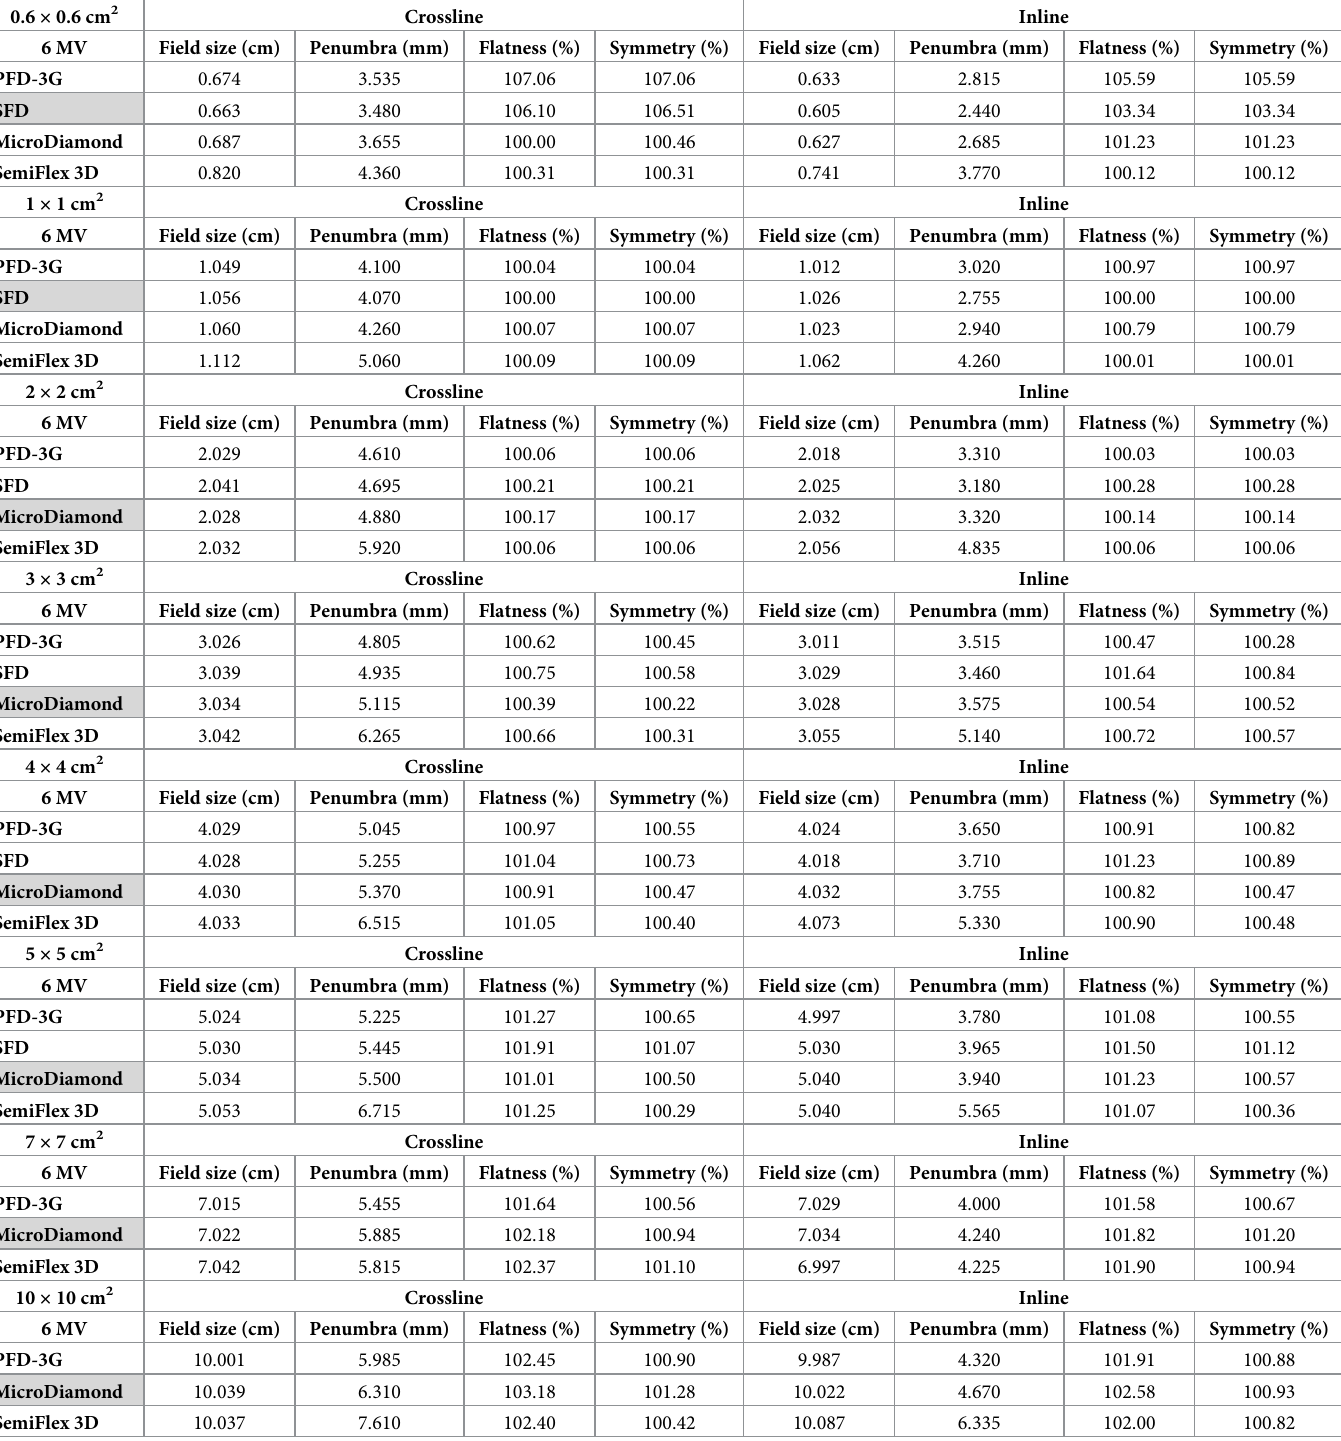
Table 6. Results of the crossline and inline profile parameters for different detectors at a 100-mm depth depending on the field size for 6 MV